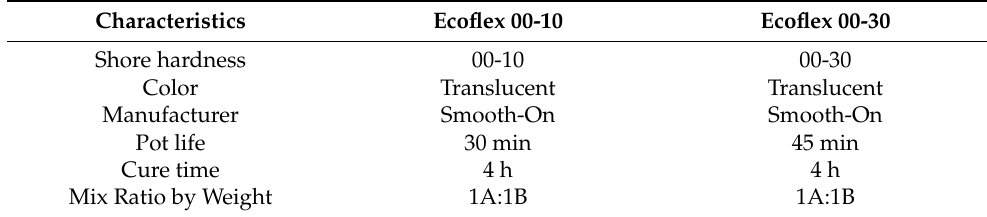
Table A1. Material characteristics of Ecoflex 00-10 and